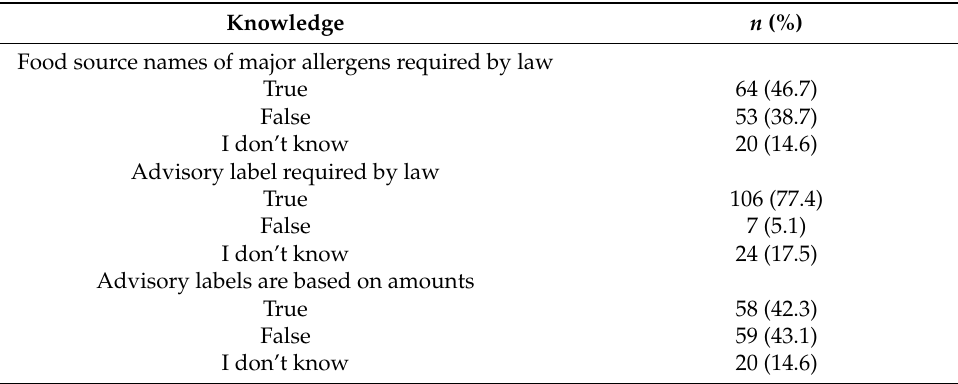
Table 5. Respondents’ knowledge about food labeling